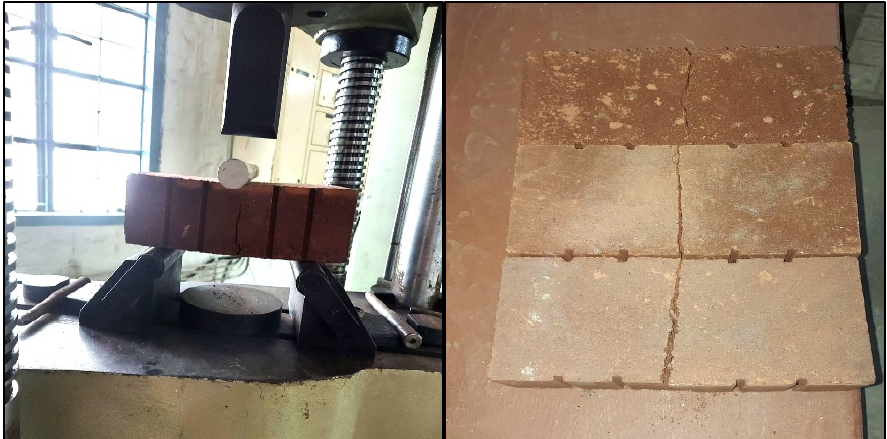
Figure 18. Flexural strength test set-up and failure after flexural test.